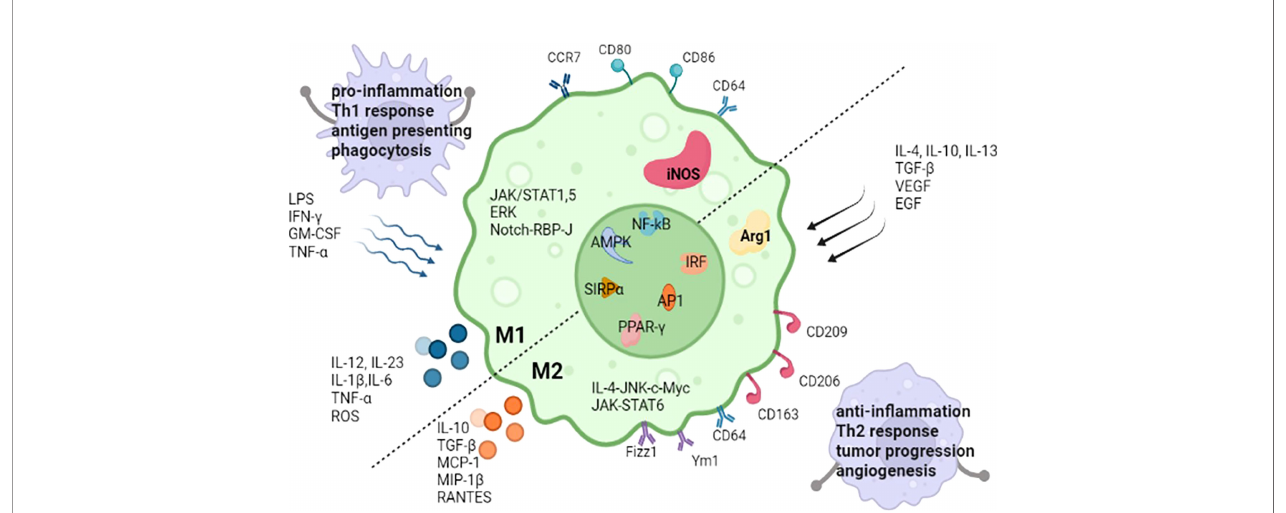
FIGURE 1 | The common transcription factors and the differences of stimuli, markers, secreted cytokines, the main regulate pathways and functions between M1 and M2 macrophages. iNOS, inducible nitric oxide synthase; Arg1, Arginase 1; LPS, lipopolysaccharides; GM-CSF, granulocyte-macrophage colony stimulating factor; IFN- g , interferon-gamma; IL, interleukin; TNF- a , tumor necrosis factor- a ; TGF ‐ b , transforming growth factor ‐ b ; ROS, reactive oxygen species; VEGF, vascular endothelial growth factor; EGF, epidermal growth factor; Ym1, chitinase 3-like 3; Fizz1, resistin-like- a ; MIP-1 b , macrophages in fl ammatory protein; MCP-1, monocyte chemo-attractant protein-1; RANTES, regulated on activation, normal T cell expressed and secreted; ERK, extracellular signal-regulated kinase; RBP-J, recombination signal-binding protein Jk; IRF, interferon ‐ regulatory factors; NF ‐ k B, nuclear factor ‐ k B; AP1, activator protein1; AMPK, adenosine monophosphate kinase; PPAR ‐ g , peroxisome proliferator ‐ activated receptor ‐ g ; SIRP a , signal regulatory protein a . RBP-J, recombination signal-binding protein